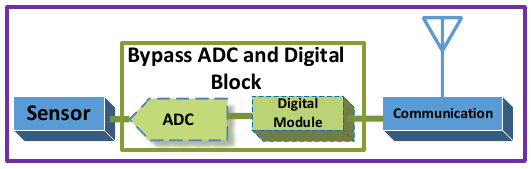
Figure 2. Block diagram battery-free